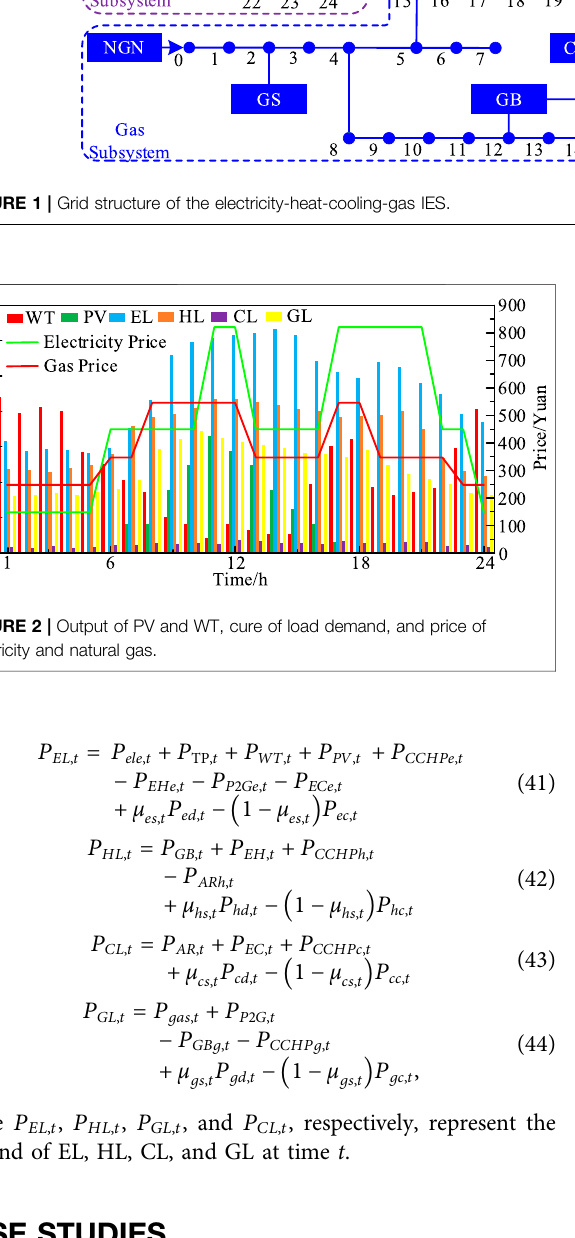
Frontiers in Energy Research |